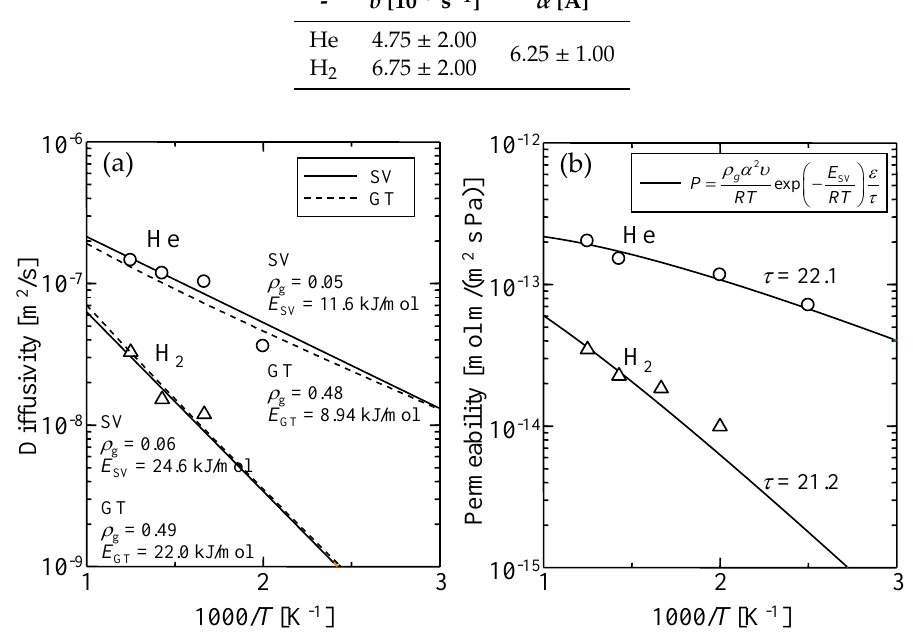
Table 6. Diffusion distance and vibration frequency of gas molecules in a virtual silica membrane structure (2.1 g/ml).